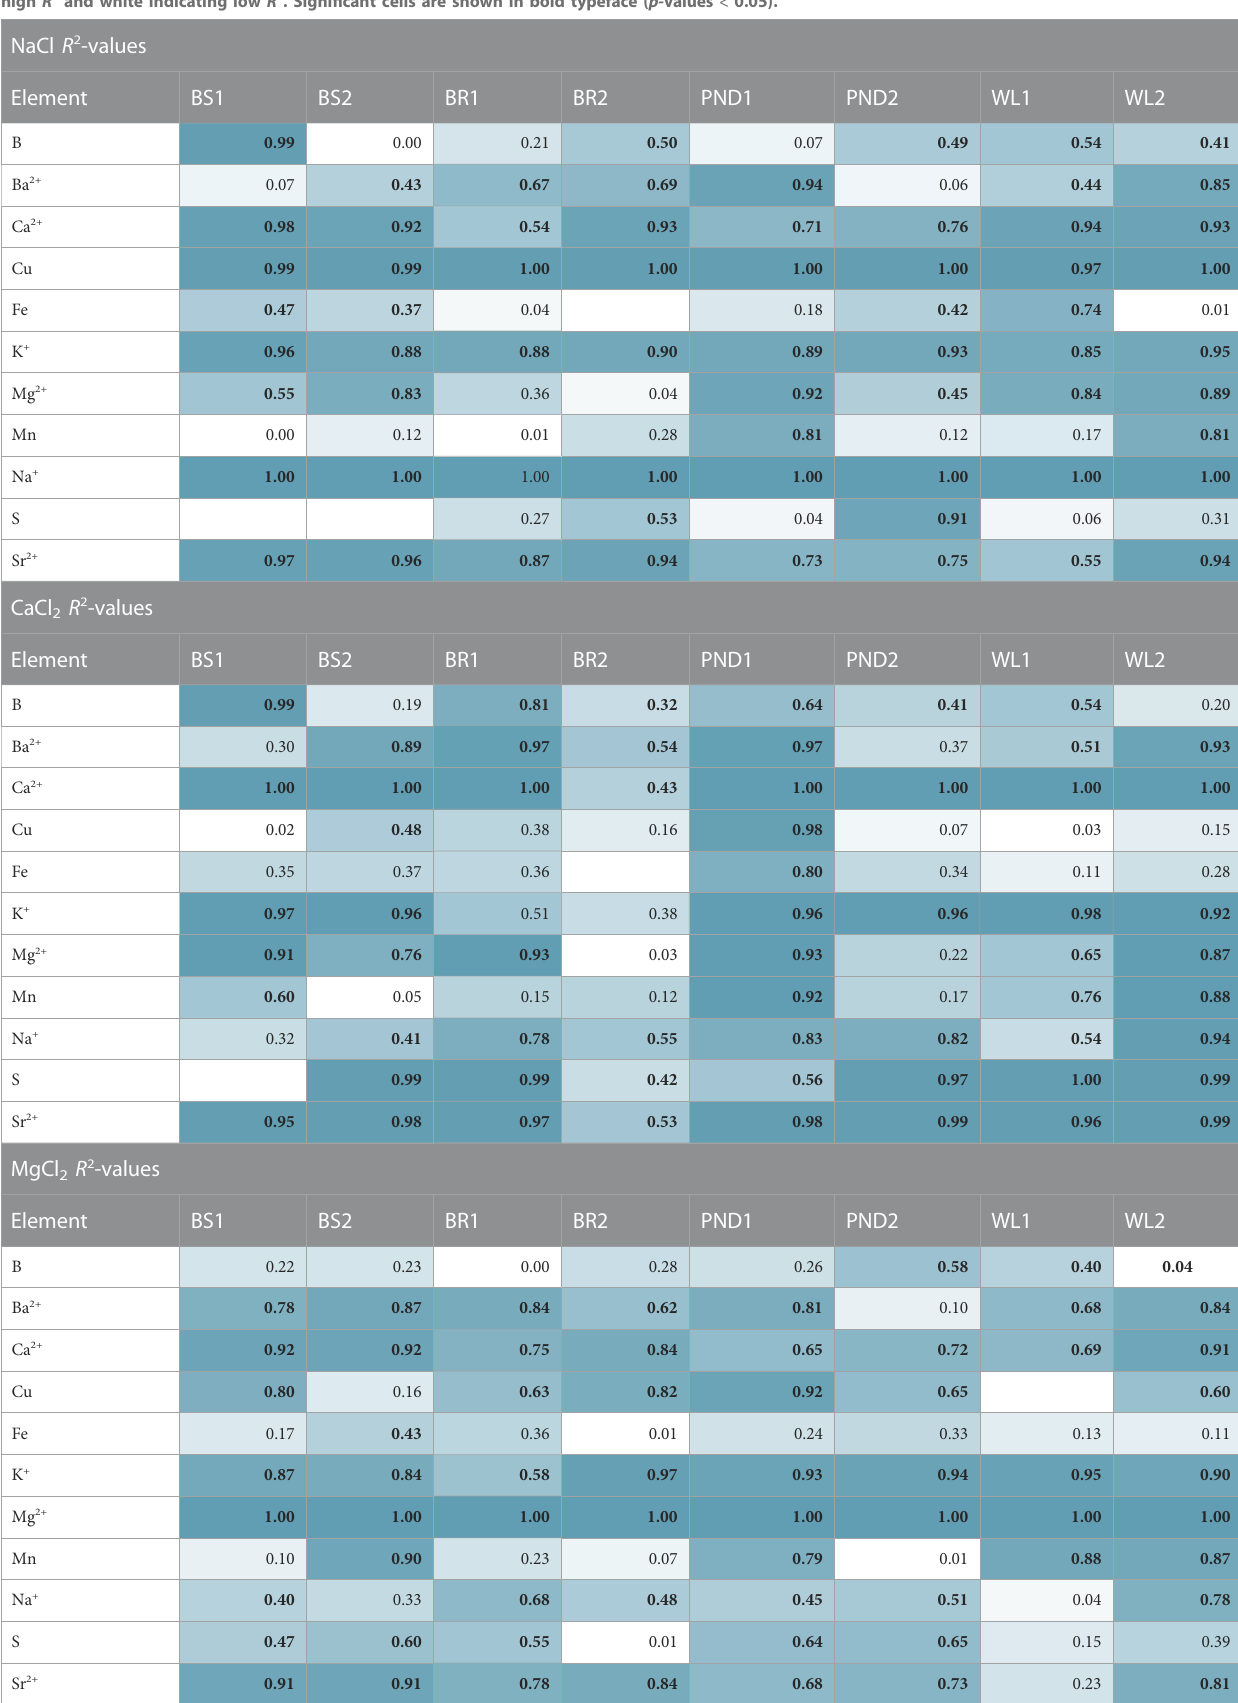
TABLE 6 Linear regression analysis of elemental concentration to Cl − concentration added in incubations. R 2 results are color coded from white to blue indicating high R 2 and white indicating low R 2 . Signi fi cant cells are shown in bold typeface ( p- values < 0.05). NaCl R 2